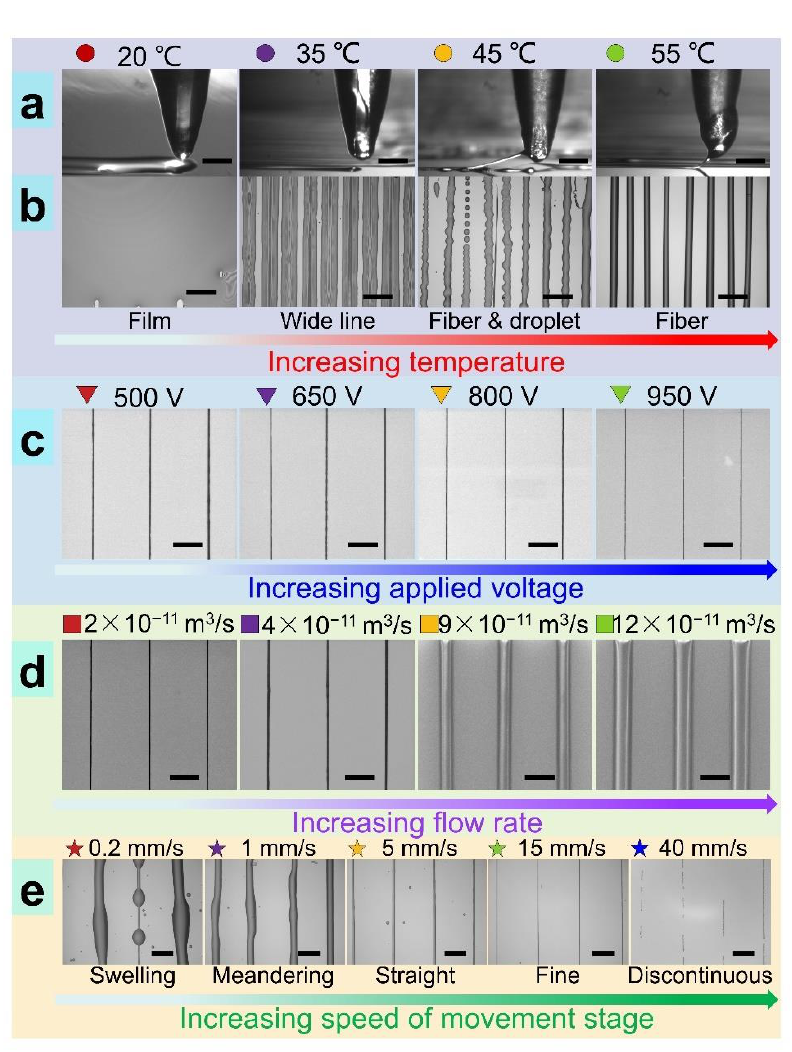
Figure 5. Diverse modes and resolution in TVEJ printing by varying selections of printing parameters. ( a ) Jet behaviors under different temperatures; ( b ) Diverse modes under different temperatures; ( c , d ) The printed resolution under different applied voltages and flow rates; ( e ) Diverse modes under different S m . (all scale, 200 µm).